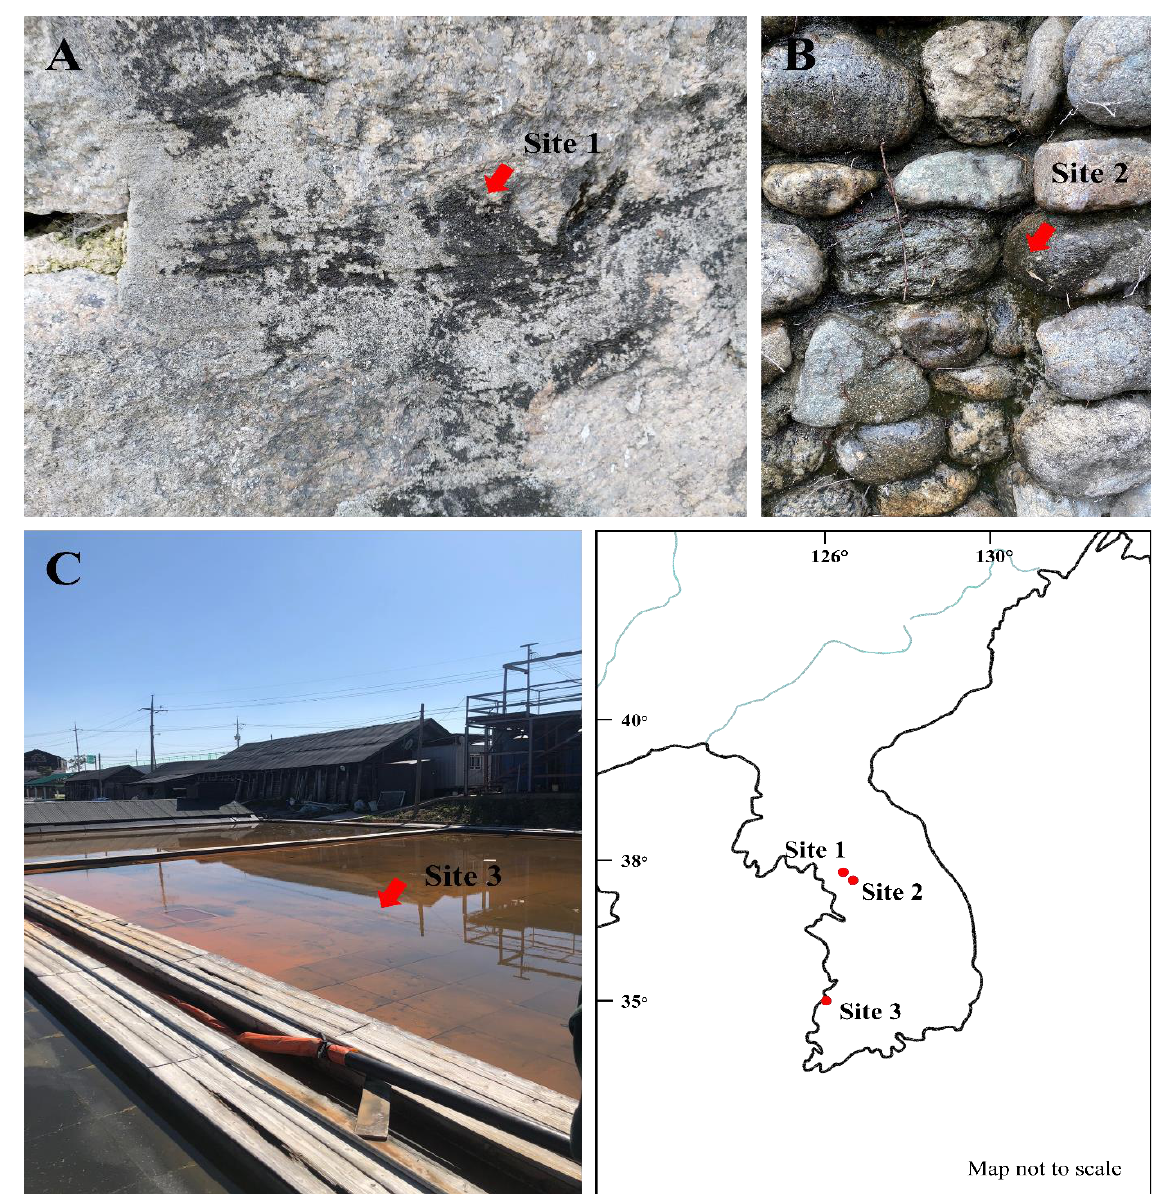
Figure 1. Photographs showing the collection sites of ( A ) Plectolyngbya koreana , ( B ) Plectolyngbya terrestris , and ( C ) Plectolyngbya salina . ( A ) Jongno-gu, Seoul, Republic of Korea (37°35 ′ 58.0 ″ N 126°57 ′ 25.8 ″ E), ( B ) Seodaemun-gu, Seoul, Republic of Korea (37°33 ′ 52.4 ″ N 126°57 ′ 43.5 ″ E), ( C ) Buan-gun, Jeollabuk-do, Republic of Korea (35°35 ′ 44.8 ″ N 126°36 ′ 44.1 ″ E), and the habitat views of the collection sites (arrows).